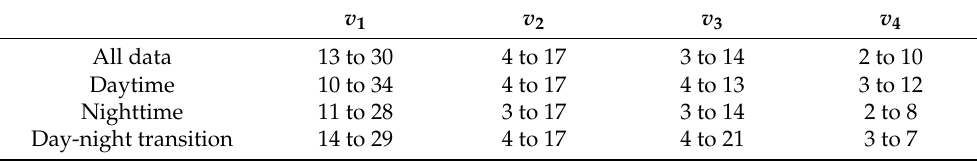
Table 3. The statistics of location errors (km) for different group velocity estimation methods. v 1 v 2 v 3 v 4 All data 13 to 30 4 to 17 3 to 14 2 to 10 Daytime 10 to 34 4 to 17 4 to 13 3 to 12 Nighttime 11 to 28 3 to 17 3 to 14 2 to 8 Day-night transition 14 to 29 4 to 17 4 to 21 3 to